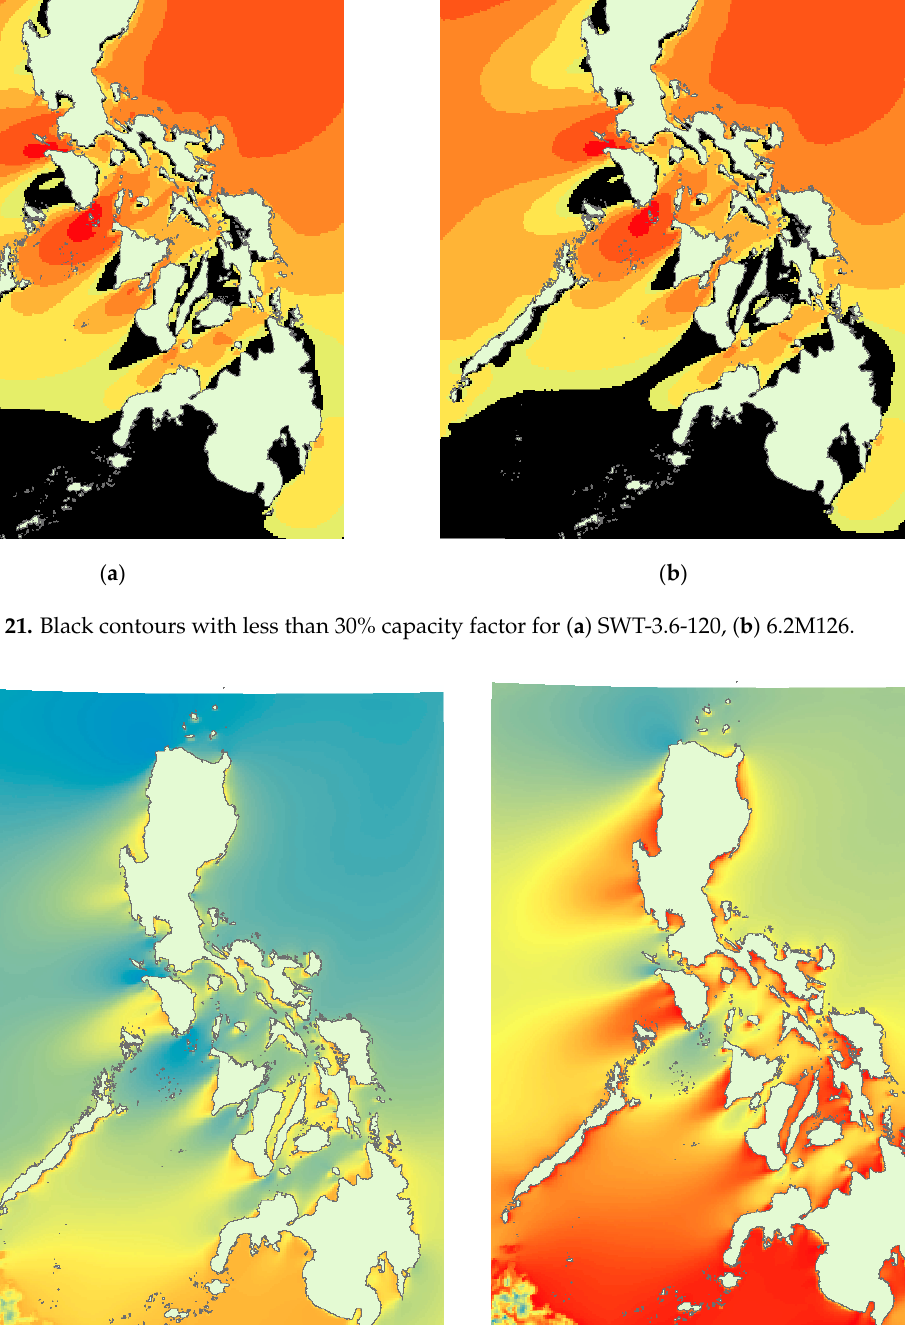
Figure 22. Performance of ( a ) SWT-3.6-120 and ( b ) 6.2M126.